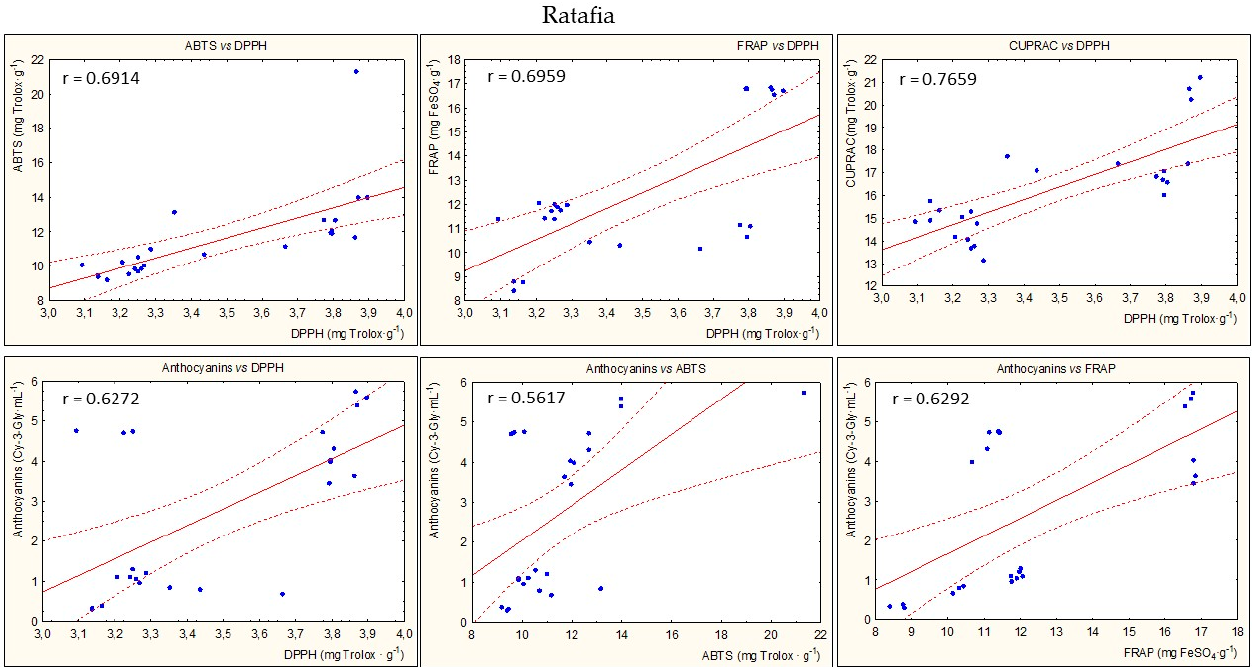
Figure 7. Cluster analysis graph for parameters antioxidant activity, total polyphenol content, and anthocyanins for all nalewkas. Years with similar values are marked with colored circles.